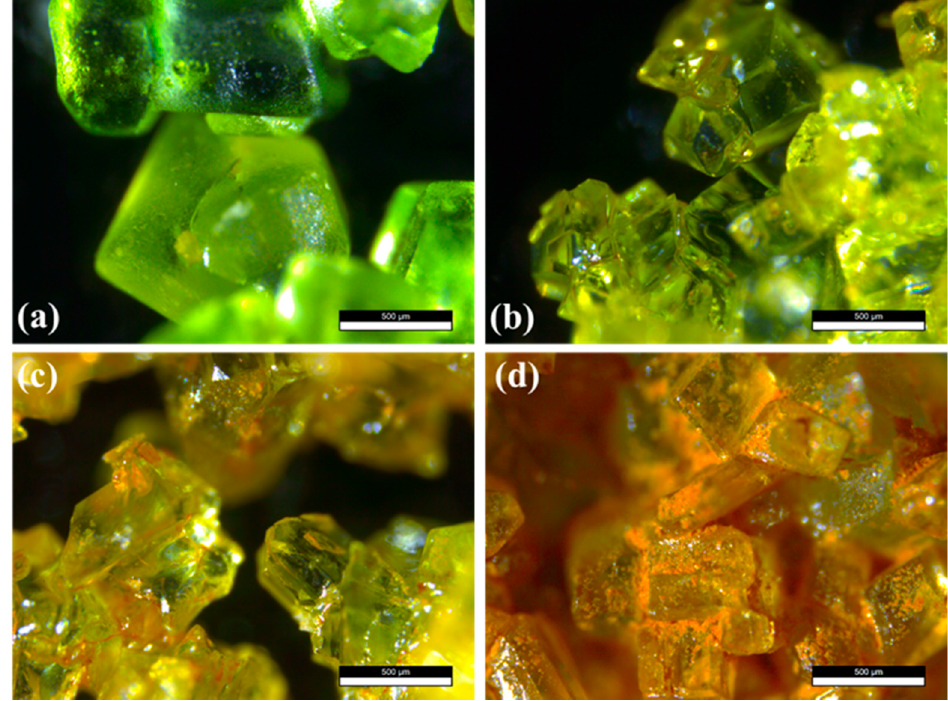
Figure 2. Optical micrographs of the FeCl 2 ·4H 2 O crystals: ( a ) commercial reference crystals (CFC). ( b ) Fresh FeCl 2 ·4H 2 O sample (FFC). ( c , d ) Images showing different stages of the aging of the crystals: ( c ) AFC; ( d ) AAFC. In all cases, the scale bar is 500 µm.